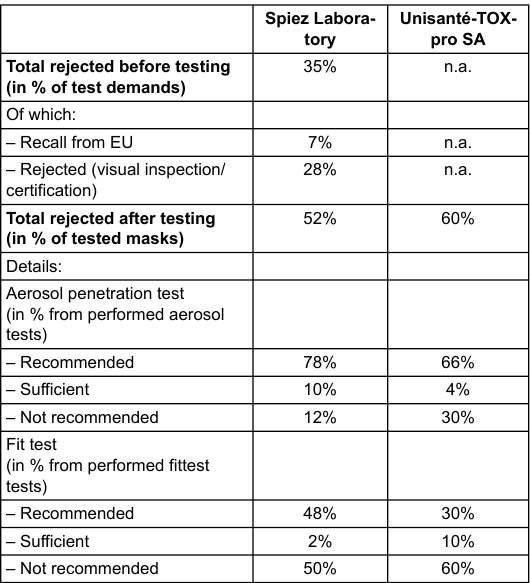
Table 1: Results of FFP respirators evaluated either by Spiez Labora- tory or by Unisanté-TOXpro SA during the COVID-19 pandemic (n =